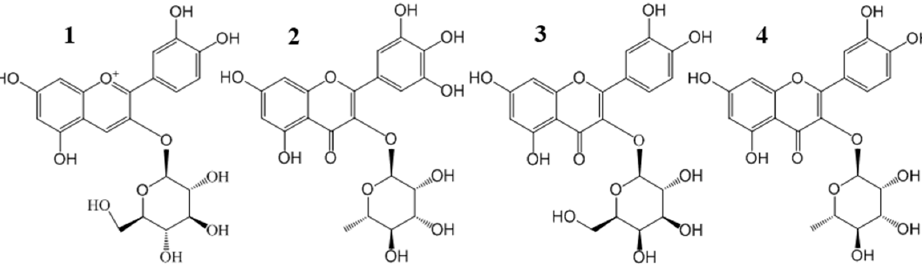
Figure 1. Chemical structures of four main flavonoid glycosides from Chinese bayberry pulp extract: cyanidin-3- O -glucoside (C3G) ( 1 ); myricetin-3- O -rhamnoside (M3R) ( 2 ); quercetin-3- O -galactoside (Q3Gal) ( 3 ); and quercetin-3- O -rhamnoside (Q3R) ( 4 ).